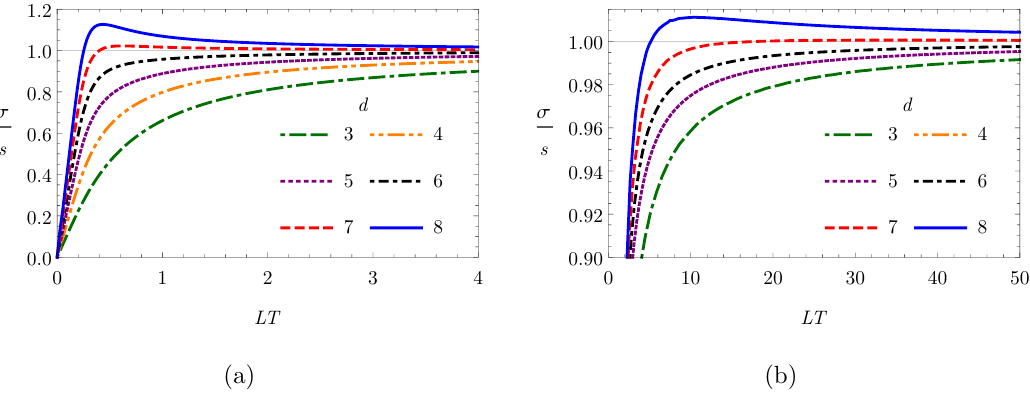
Figure 7. The ED, (cid:27) , in units of entropy density s , versus LT for (a) the strip, and (b) the sphere, for AdS-SCH in d = 3 ; 4 ; : : : ; 8. For each entangling surface, when d = 3 ; 4 ; 5 ; 6 < d crit (cid:25) 6 : 7, (cid:27)=s monotonically increases with LT and (cid:27)=s ! 1 (cid:0) as L ! 1 , whereas when d = 7 ; 8 > d crit , (cid:27)=s rises to a global maximum before (cid:27)=s ! 1 + as LT ! 1